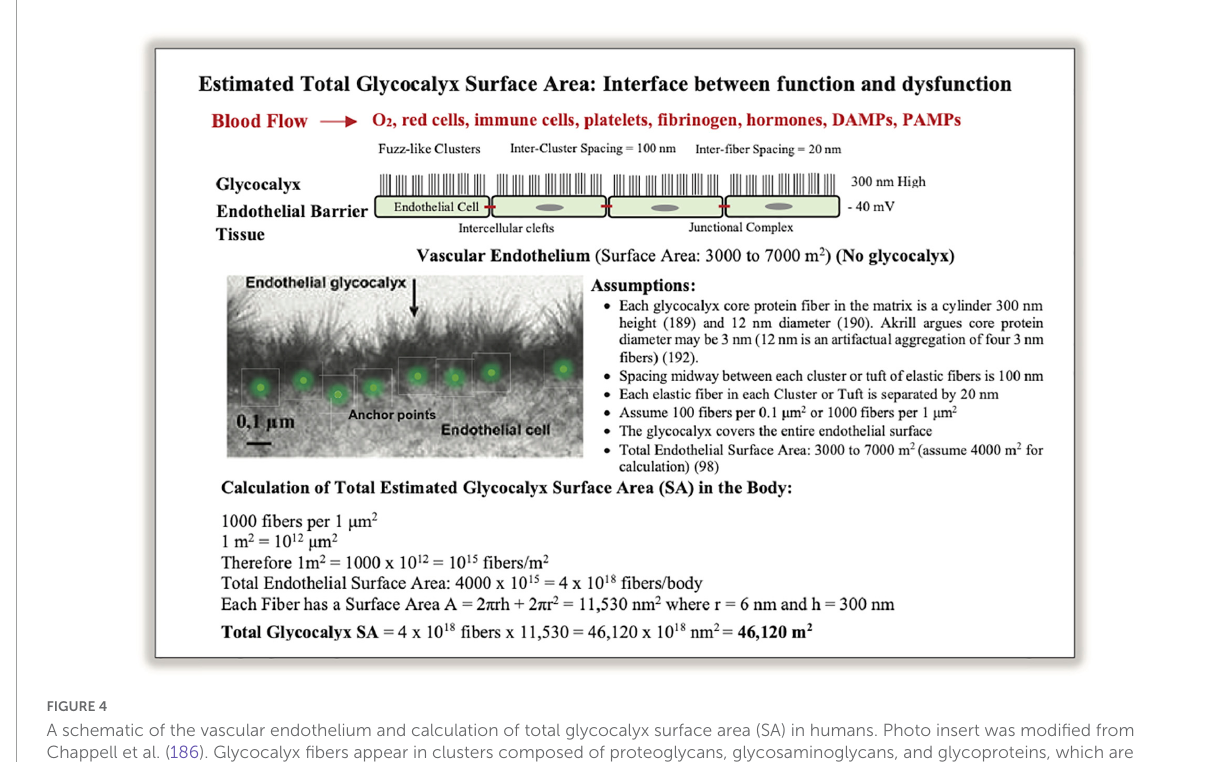
FIGURE4 A schematic of the vascular endothelium and calculation of total glycocalyx surface area (SA) in humans. Photo insert was modified from Chappell et al. (186). Glycocalyx fibers appear in clusters composed of proteoglycans, glycosaminoglycans, and glycoproteins, which are anchored into endothelial cells by core-proteins (113, 115, 187, 188). Together they form a dynamic structure that participates in shear stress regulation, barrier protection, vascular permeability, inflammation, coagulopathy, fibrinolysis, mechanotransduction, immune function and cytokine signaling (97, 101, 104, 116). The glycocalyx is difficult to characterize because of its fragility and instability, and its structural dimensions critically depend on the method of ultrastructural visualization (97, 116, 189–193). The SA calculation should be viewed as approximate. A glycocalyx SA of 44,120 m 2 for material exchange equates to ∼ 200 tennis courts or over 8 US football fields (see